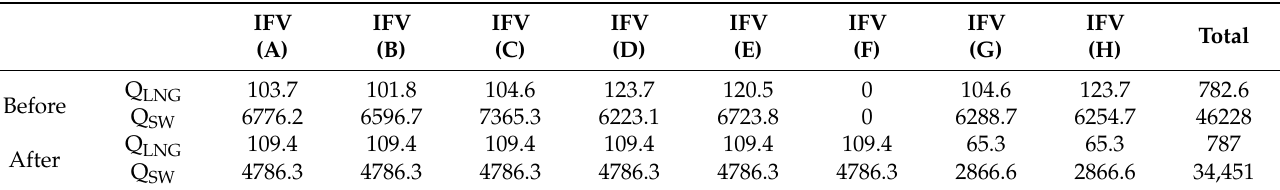
Table 2. IFV operation configuration scheme with a total processing capacity of 782.6 t/h and seawater temperature of 8 ◦ C.